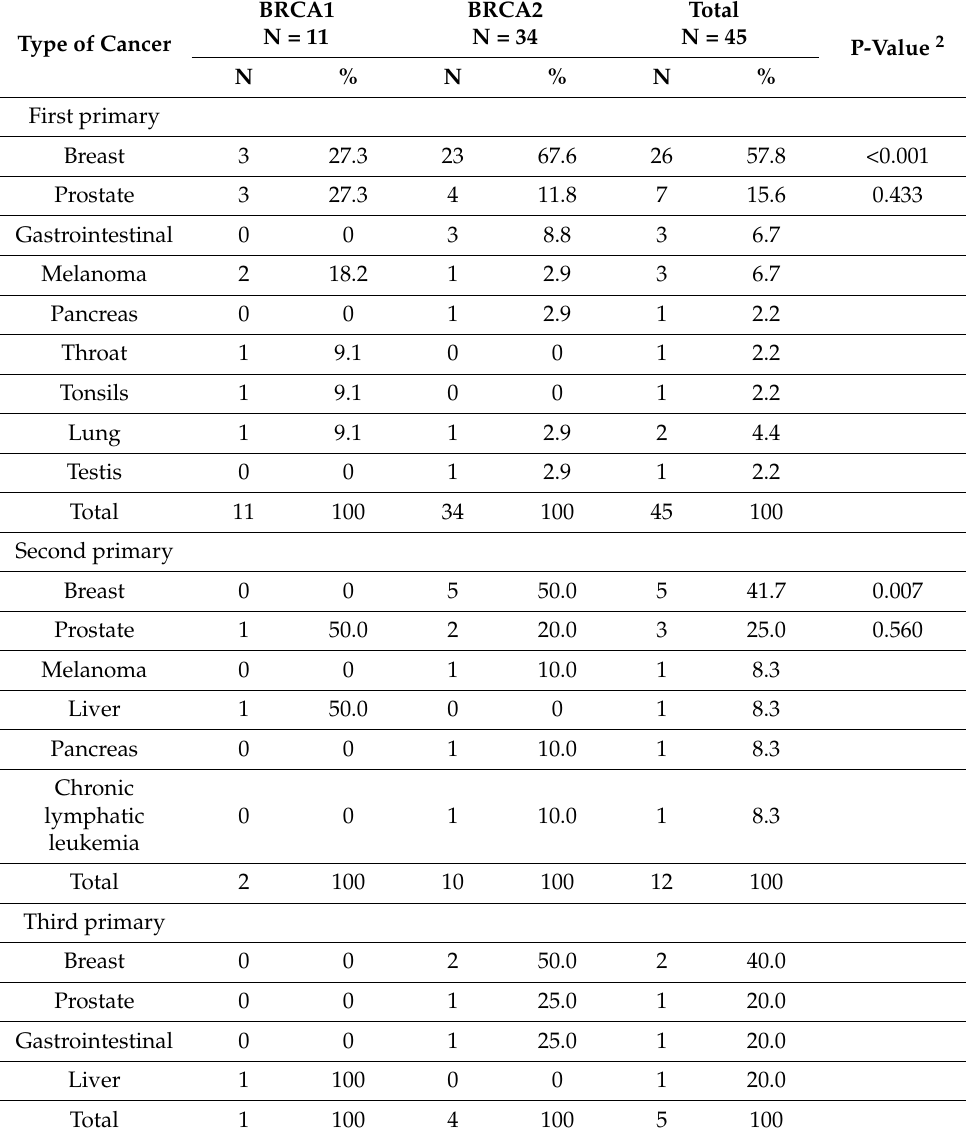
Table 2. Cancer spectrum of BRCA1/2-mutation carriers 1